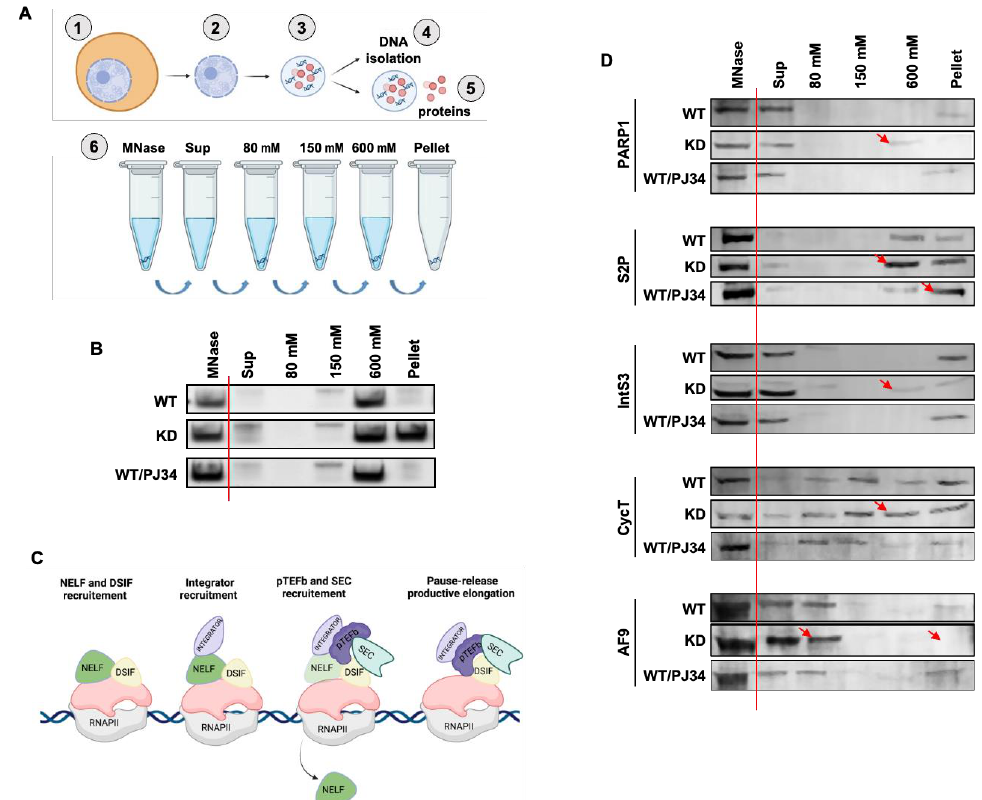
Figure 3. PARP1 modulates the subcellular localization of key elongation factors. Chromatin salt fractionation of PARP1, RNAPII, and elongation factors in WT-, PARP-KD-, and PJ34-treated cells. ( A ) Schematic representation of nuclear fractionation protocol. Chromatin from ~5 × 10 7 cells was digested to mono-nucleosome length using MNase and the digested chromatin subjected to salt fractionation with increasing salt concentrations. DNA isolated from each step was used to confirm validity of protocol. ( B ) DNA released under the different salt concentrations was analyzed on a 4% NuSieve™ agarose gel. ( C ) Known model of the association of elongation complexes during RNAPII elongation in the gene body. We then tested the effect of PARP1 on the integrator and SEC complexes. ( D ) Western blot of different salt fractionation steps with antibody against PARP1, RNAPII elongating (S2P), IntS3 and several chromatin-associated elongation factors (Integrator: IntS3), p-TEFb (CycT) and super elongation complex (AF9). Arrows indicate differences observed in protein shifts.